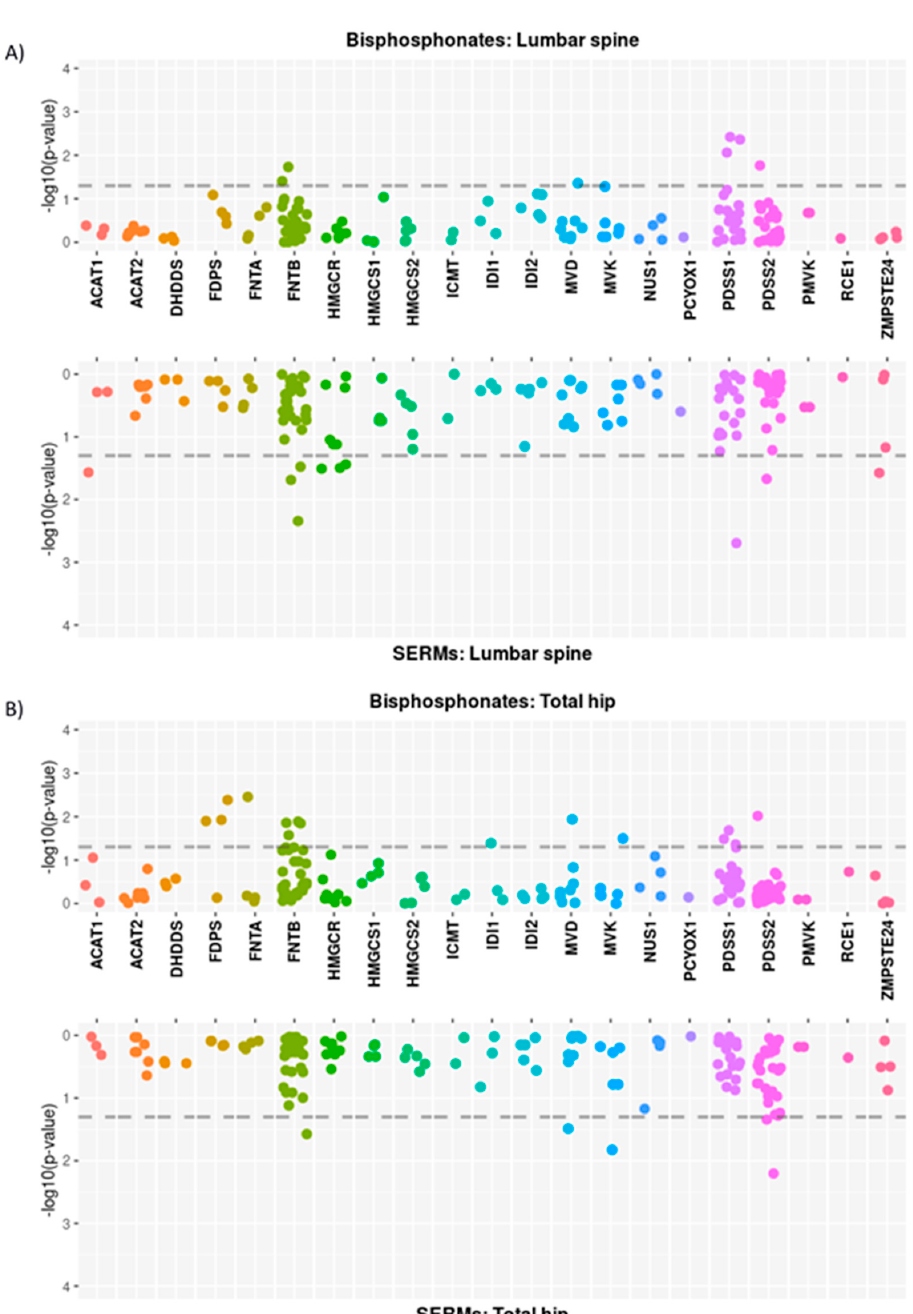
Figure 2. Miami plots showing the p ‐ values of the association between mevalonate pathway SNPs and annual BMD change at the spine ( A ) and hip ( B ). For both regions, the results of the BP ‐ treated group (upward) and the SERM ‐ treated groups (downward) are shown.